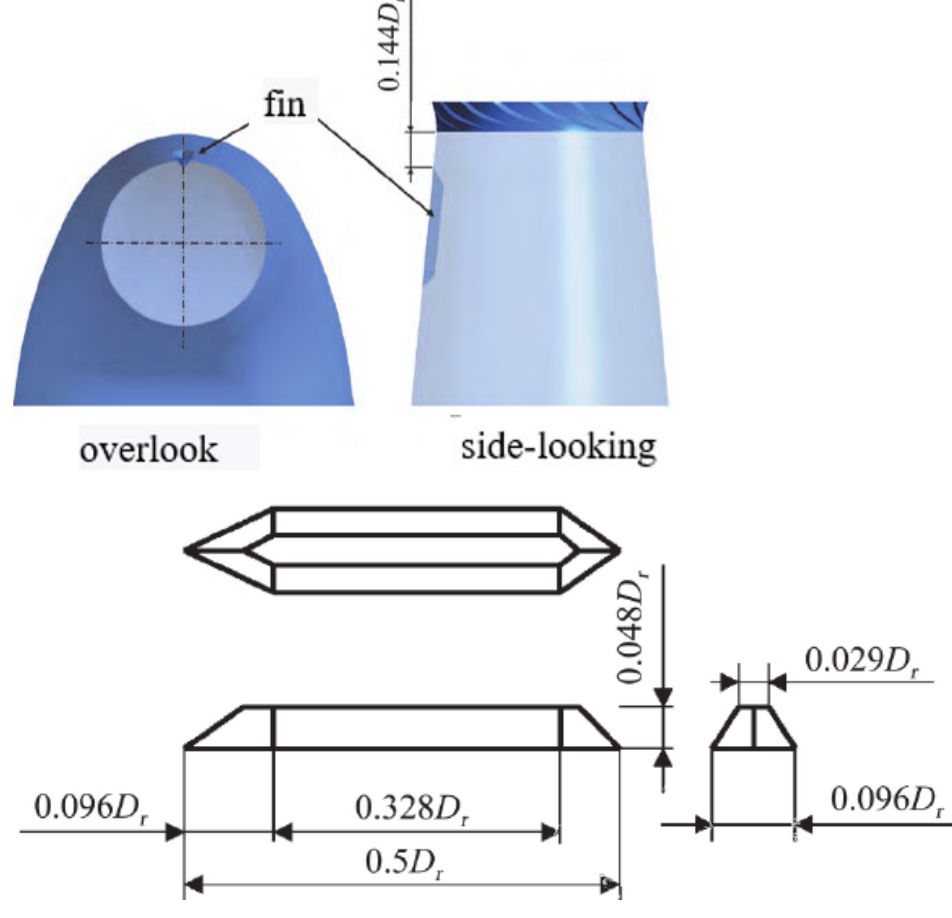
Figure 10. Installation position and size of diversion plate [62]. Compared with the more complex structure of the fin, the structure of the diversion baffle is relatively simple. Through the study, it was found that the best effect is to add a diversion baffle in the cone section of the entrance taper pipe, the upper end of the baffle should be close to the entrance taper pipe, and the vertical height of the baffle should not be less than 40% of the diameter of the runner. The width, height, thickness, and other factors in the vortex rope [63]. The existence of a diversion baffle also has a positive effect on the downstream internal flow pattern [64]. Under the action of the runner, the water flow still has a large circumferential velocity component before entering the draft tube. When the fluid passes through the baffle completely, the circumferential velocity component of the same rotation direction of the fluid and the runner is gradually reduced. The velocity